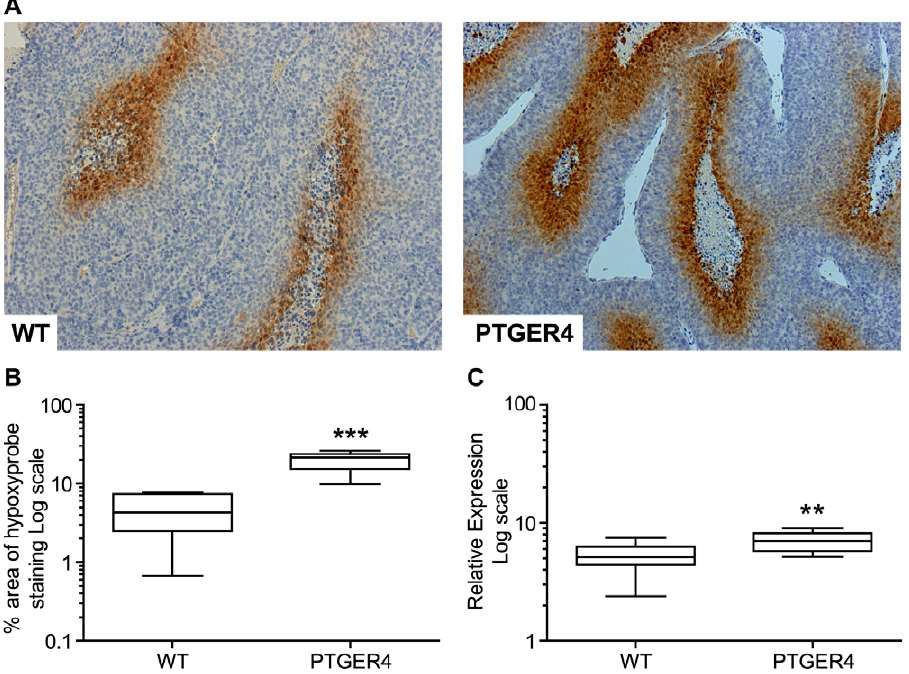
Figure 5. PTGER4 xenograft tumours display increased areas of hypoxia compared with WT control. Immunohistochemistry for detection of hypoxia in WT (n=5 sections) and PTGER4 (n=5 sections) xenograft tumours as determined by staining for the Hypoxyprobe pimonidazole. ( B ) Quantitative stereology of hypoxia in WT and PTGER4 xenograft tumours as determined by percentage area stained positive for Hypoxyprobe. ( C ) mRNA expression of the hypoxia inducible factor HIF1 a in WT (n=10) and PTGER4 (n=10) xenograft tumours. **, *** represents significance at P , 0.01 and P , 0.001 for PTGER4 versus WT respectively.